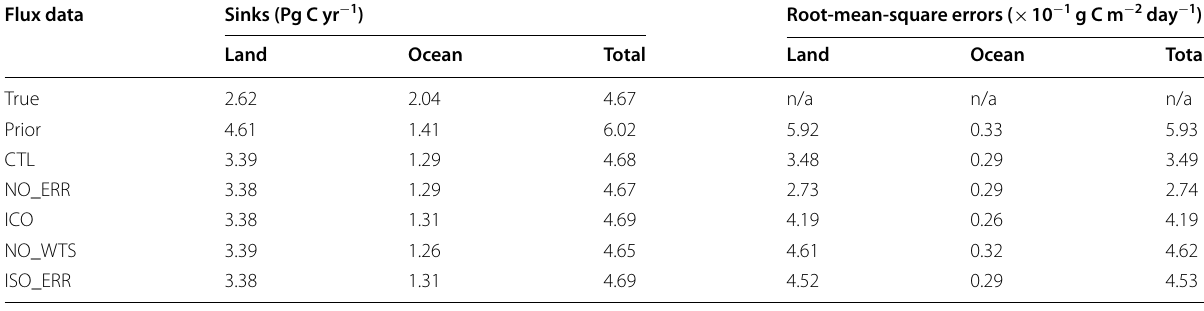
Table 2 Global-scale net sinks and errors for 2008–2017. The sink values do not include fossil fuel emissions. These errors are derived using root-mean-square errors against the true fluxes over the land, the ocean, and the global total carbon fluxes